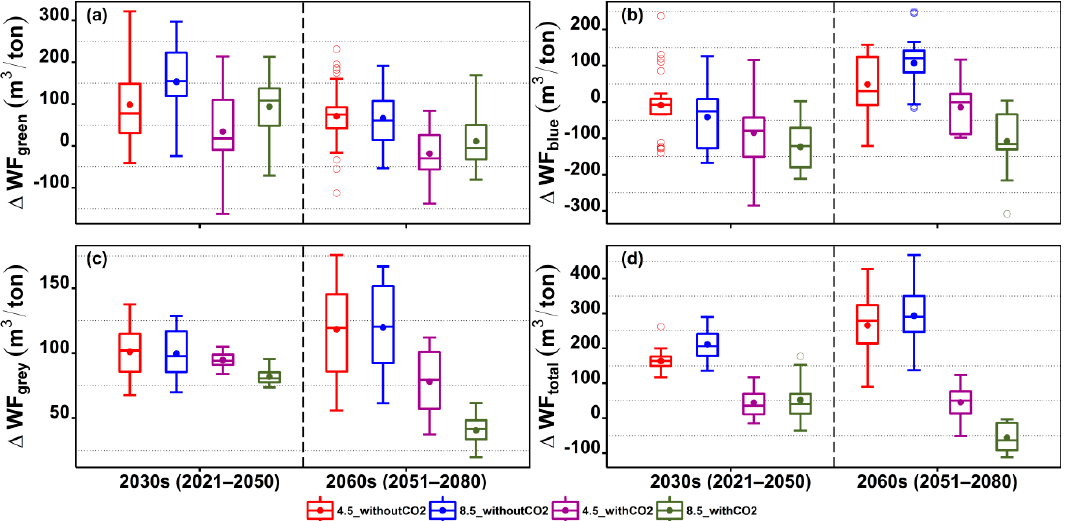
Figure 12. Projected changes in (a) green water footprint (WF green ), (b) blue water footprint (WF blue ), (c) grey water footprint (WF grey ) and (d) total water footprints (WF total ) for wheat during the future time slices. The boxes in Figure 12a–d represent the inter-quartile range (IQR), the whiskers extend up to 1.5 times the IQR, the dots and horizontal lines inside the boxes represent mean and median, respectively, and outliers are shown as hollow dots outside the boxes. Each box shows the difference of baseline average values with the mean value of nine GCMs.